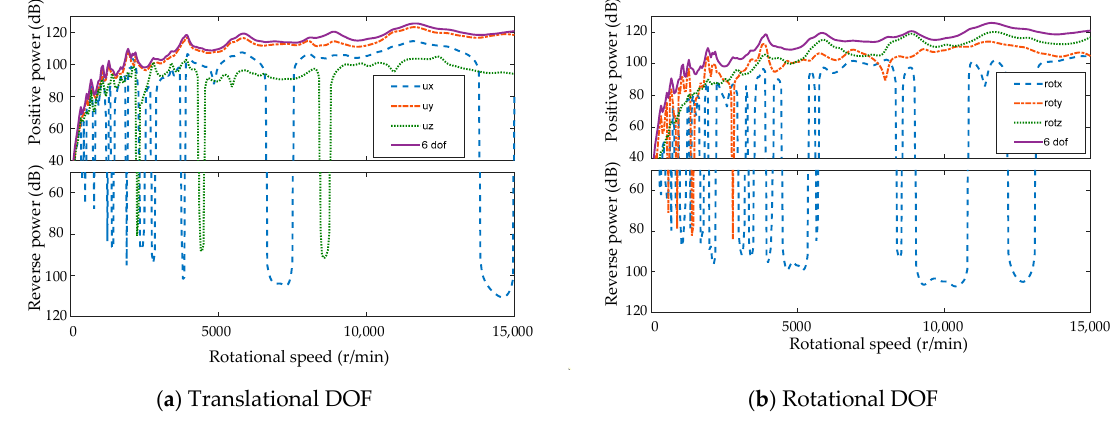
Figure 10. Gear shaft transmi tt ed power fl ow—direction path.